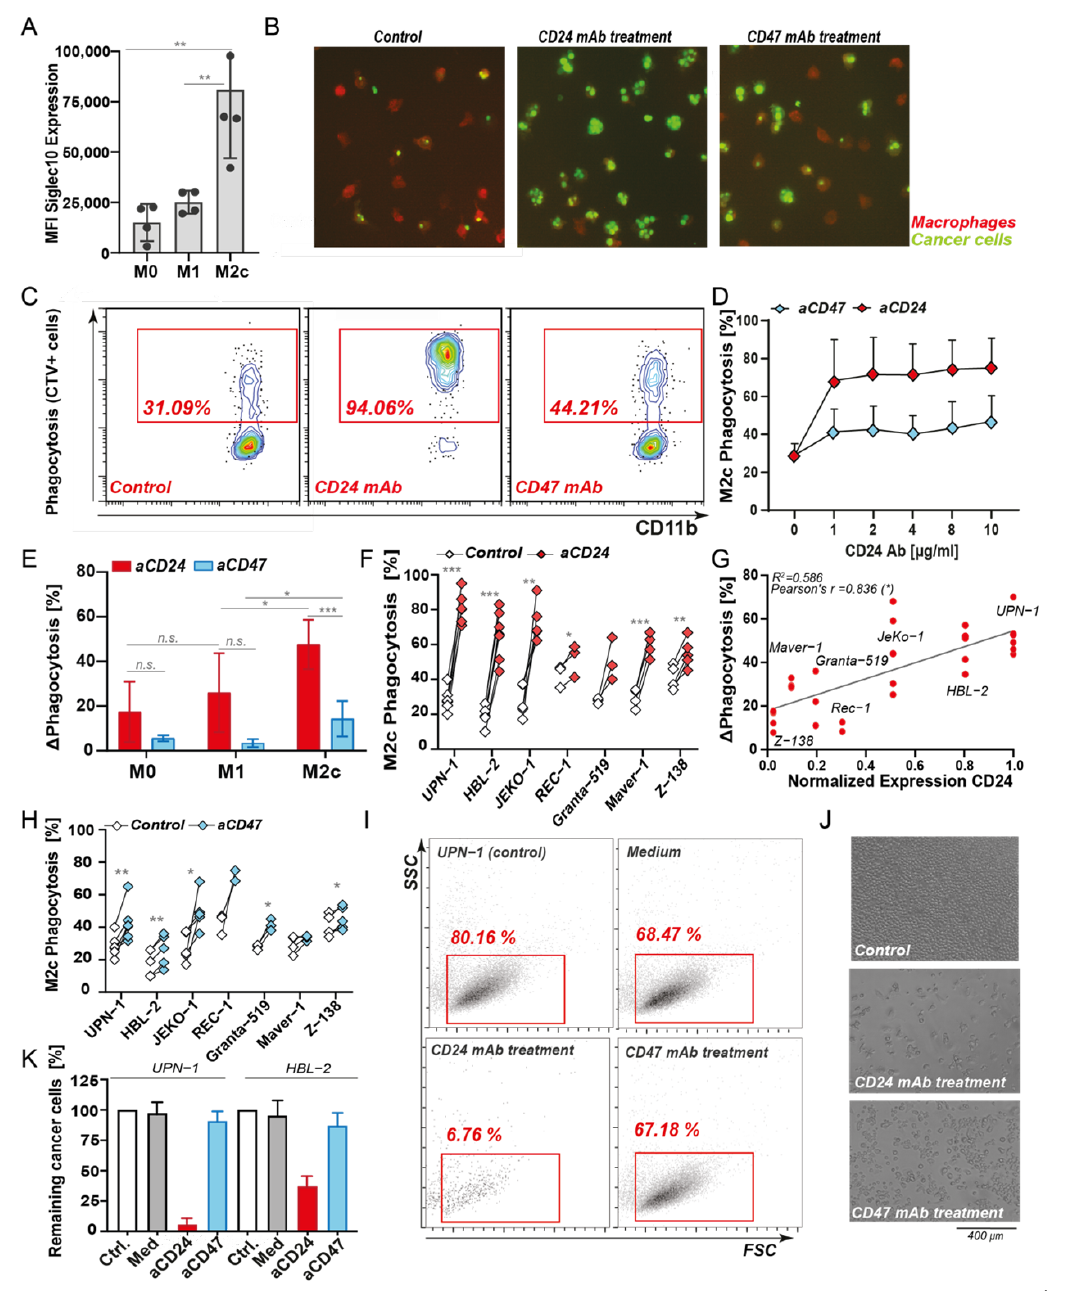
Figure 2. Phagocytic uptake and clearance of MCL cell lines upon CD24 and CD47 antibody treatment. ( A ) Levels of Siglec10 expression in M0, M1, and M2c type macrophages. ( B ) Microscopy images of macrophage-mediated phagocytosis of UPN-1 cells in M2c mixed culture (control, left), CD24 antibody SN3 (middle) or CD47 mAb InhibRx treatment (right), with macrophages in red (CD11b) and cancer cells in green (CSFE). ( C ) Flow cytometry analysis of UPN-1 phagocytosis with cell trace violet (CTV)-stained cancer cells and macrophages stained with CD11b-APC. Level of phagocytosis was determined as the percentage of CD11b+CTV+ cells. ( D ) Dose range of CD24 antibody SN3 and CD47 antibody InhibRx treatment in UPN-1 cells. ( E ) Phagocytosis levels of UPN-1 cells by M0, M1, and M2c-polarized macrophages upon SN3 and InhibRx treatment. ( F ) Percentage of phagocytosis upon CD24 SN3 antibody treatment vs. medium control of several MCL cell lines by M2c macrophages (of at least 3 independent donors). ( G ) Correlation between CD24 expression and increase in phagocytosis upon CD24 SN3 treatment in MCL cell lines. CD24 expression was normalized to the highest value, corresponding to UPN- 1 CD24 expression. Pearson’s r = 0.836 (*) and linear regression p < 0.05. ( H ) Percentage of phagocytosis upon CD47 InhibRx treatment vs. medium control by M2c macrophages (of at least 3 independent donors) in several MCL cell lines.